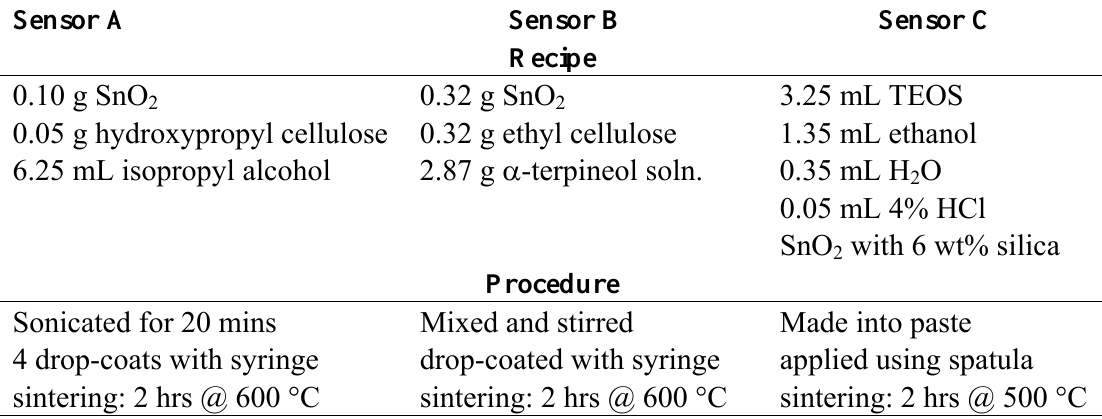
Table 1. Binder-paste recipes and film preparation